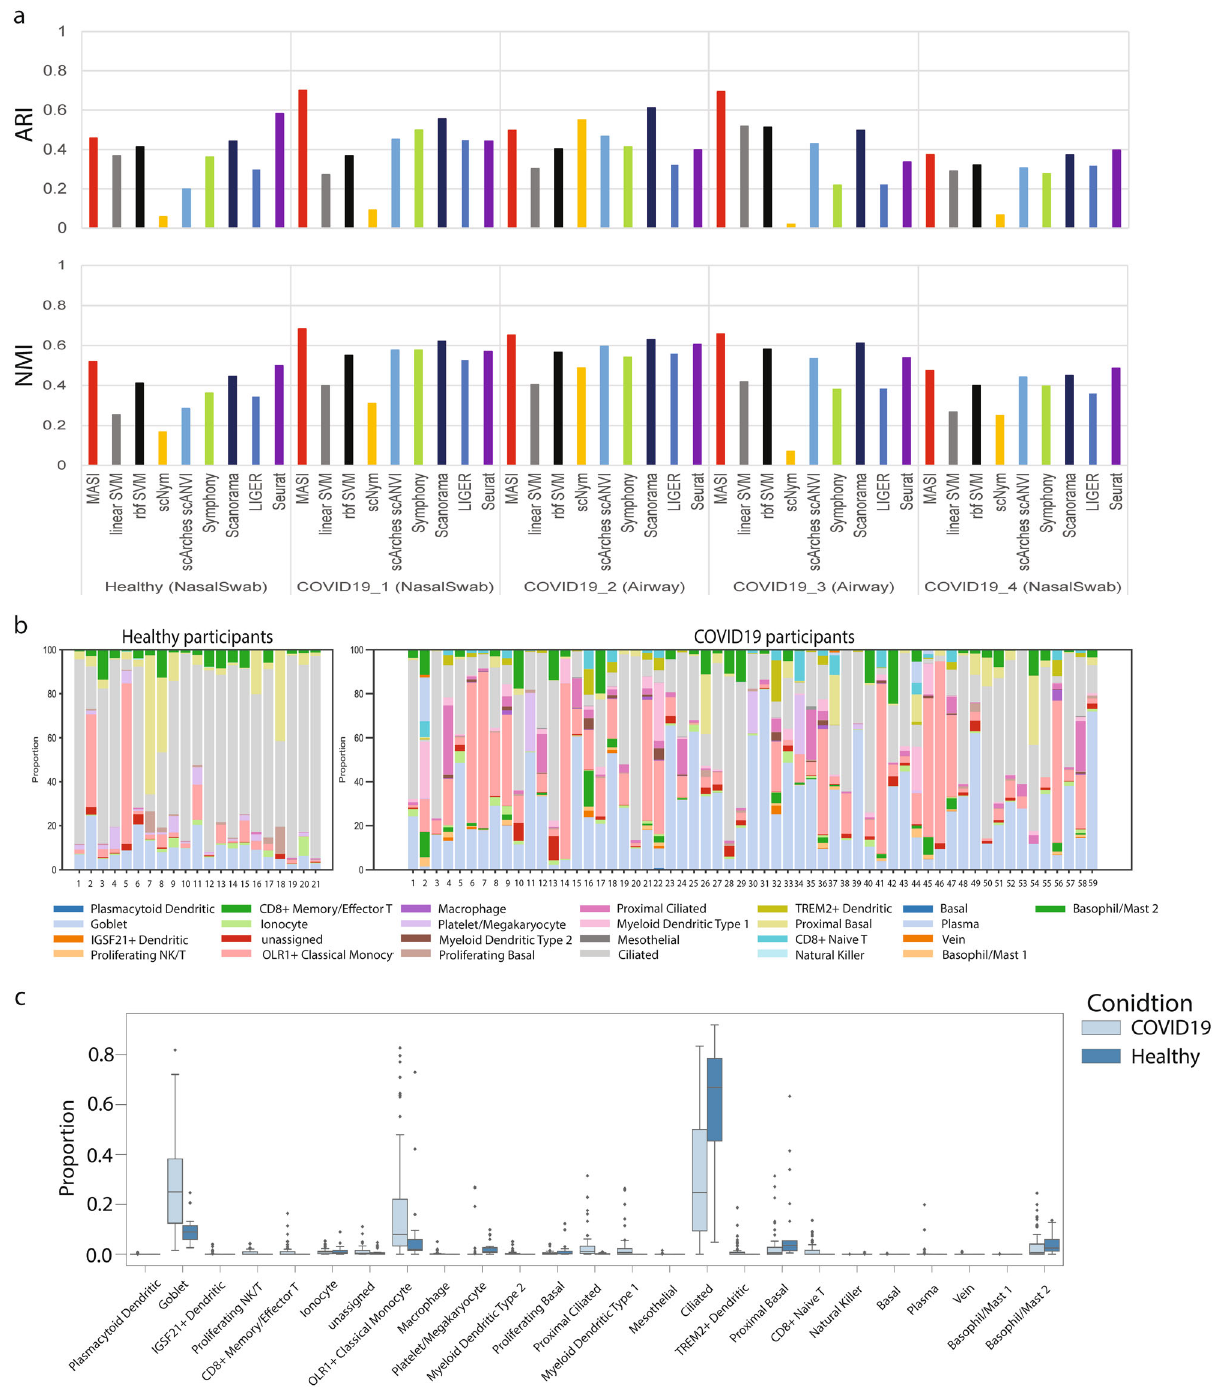
Fig. 5 Transferring human lung atlas for integration of single-cell COVID-19 data across individuals. a Comparison of label transferring for MASI, supervised, and semi-supervised methods. ARI and NMI are calculated by comparing method-reported annotation with author-reported annotation in a study-wise manner. b Cellular compositions of healthy and COVID-19 participants 14,15 . Each column represents one individual. c Cellular composition comparison of healthy and COVID-19 participants. A box covers 25th percentile to 75th percentile samples. Within a box, a median line was drawn. Bottom and top error bar lines de fi ne 5-percentile and